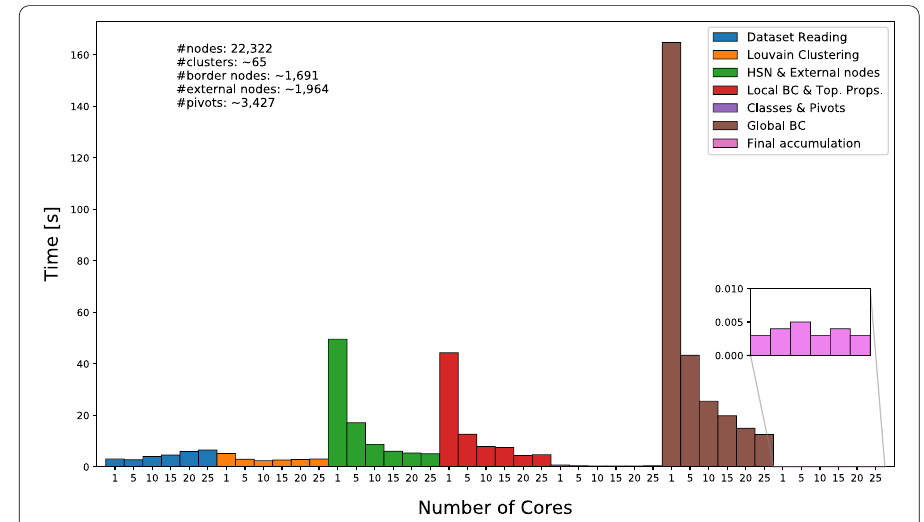
Fig. 15 Breakdown analysis of computation time on real graph